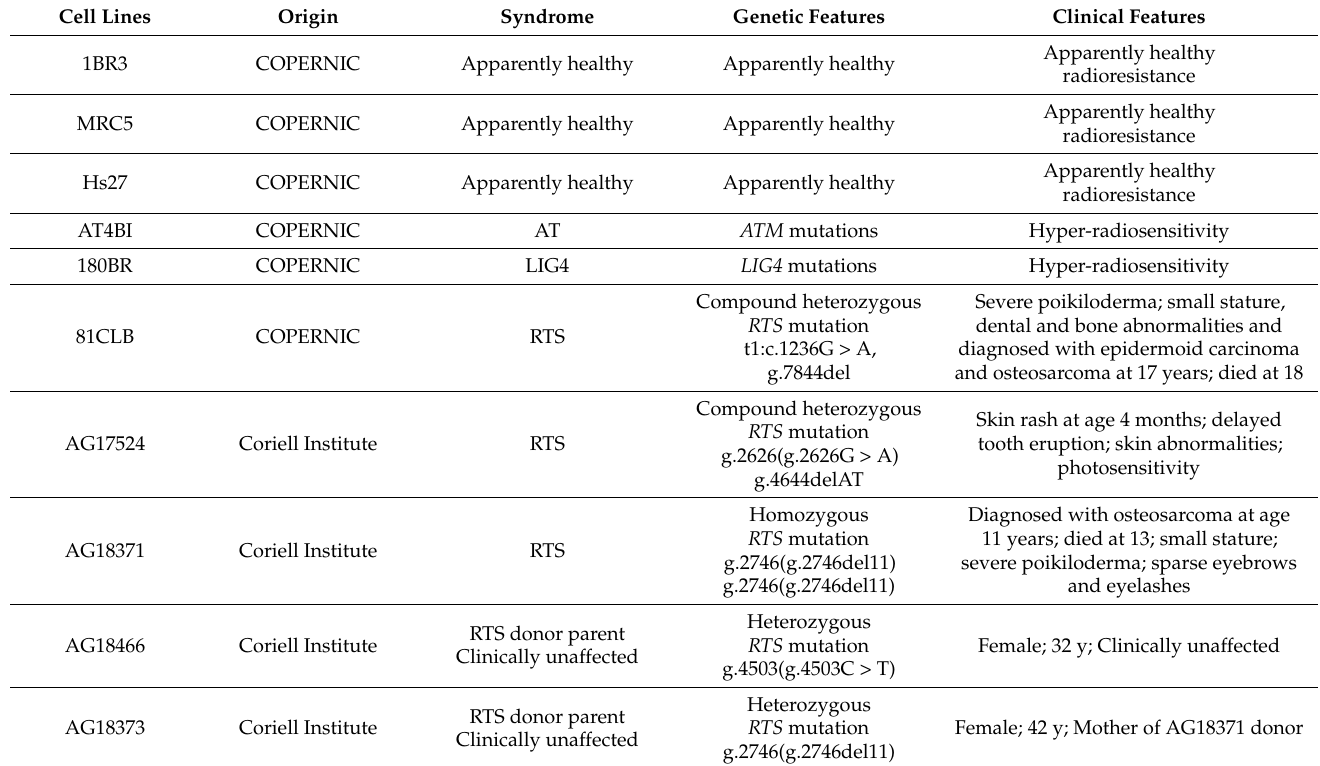
Table 3. Non-exhaustive list of studies dealing with the radiobiological characterization of RTS